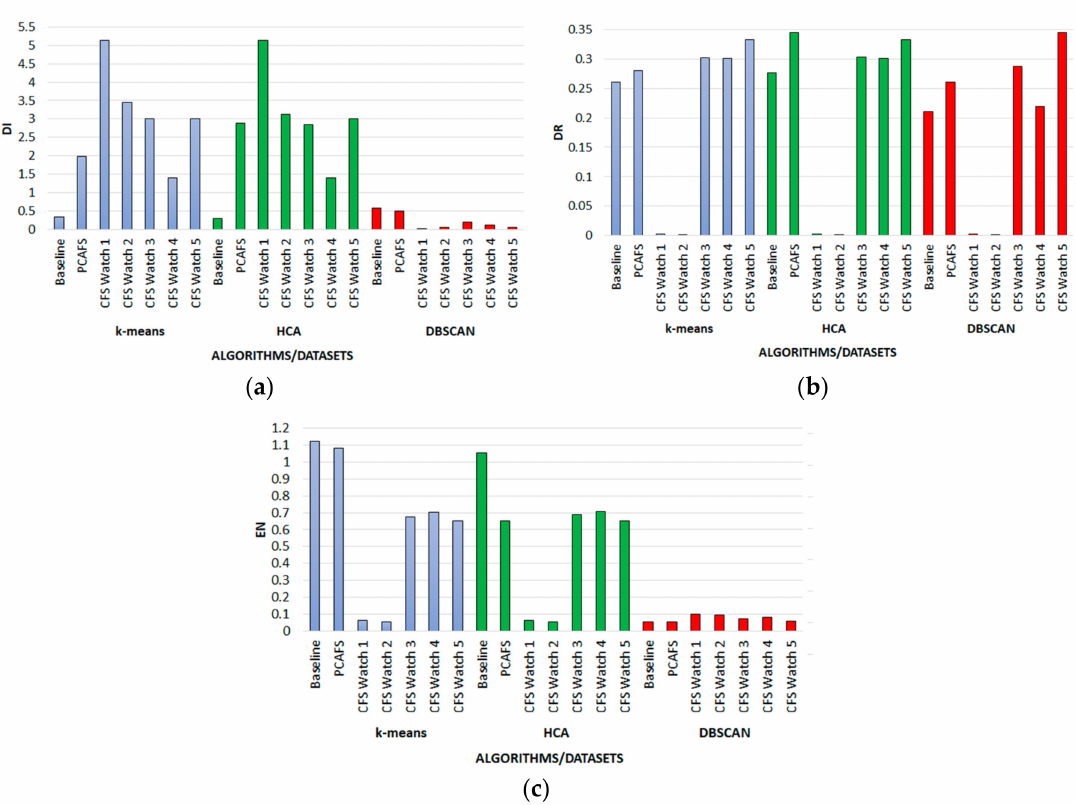
Figure 7. Clustering validation of the Watch datasets that illustrates ( a ) Dunn Index (DI), ( b ) distance ratio (DR), and ( c ) entropy